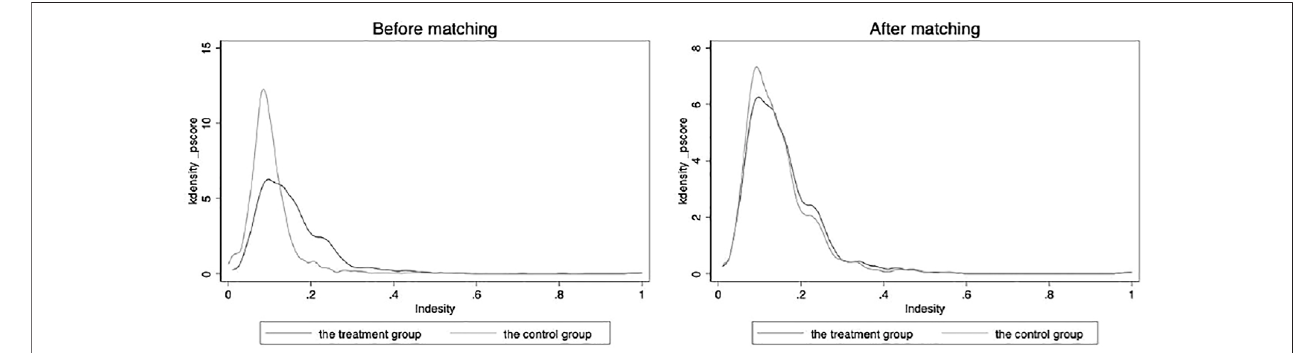
FIGURE 1 | Kernel density distribution of the tendency scores.